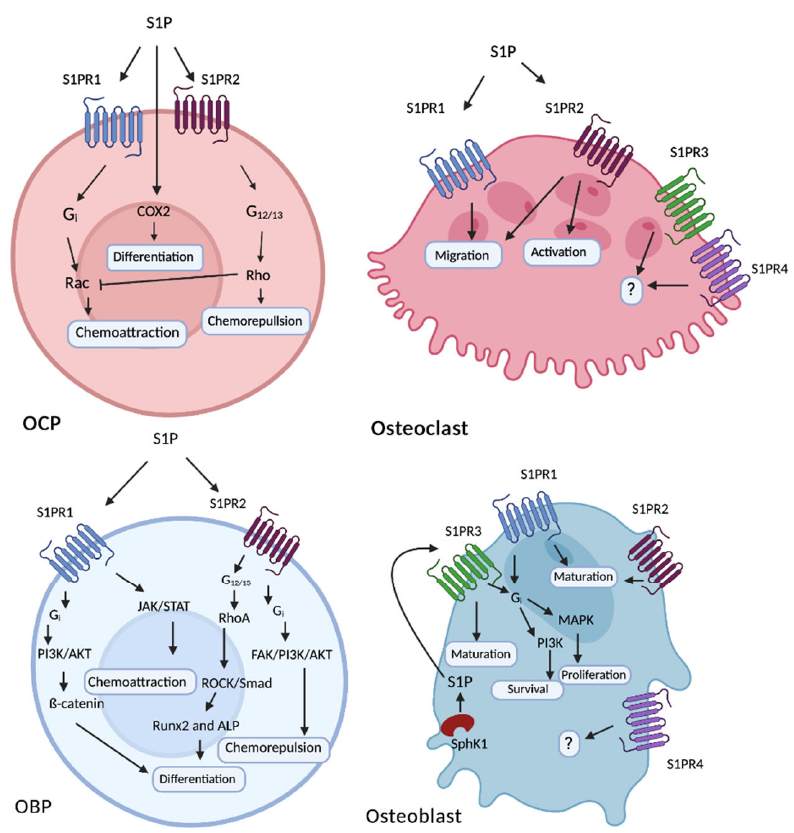
Figure 2. S1PR function in osteogenic cells. Schematic representation of the downstream signalling from S1PRs in osteoclast precursors (OCPs), osteoclasts (OCs), osteoblast precursors (OBPs), and osteoblasts (OBs). S1PRs are G-protein coupled receptors that activate various pathways and are present at different stages of OB and OC differentiation [17]. Within OCPs, S1PR1 and S1PR2 alter OC maturation via activation of Rho and Rac signalling pathways [24]. S1P can increase OCPs differentiation via Cox2, although the mechanism is not fully understood [24]. Although S1PR1-4 are expressed in OCs, the role of S1PR3 and S1PR4 are not currently understood [30]. S1PR1/2 can alter OC migration but the mechanisms underpinning this remain unclear. S1PR2 appears to be essential for OC activation. Within OBs, S1PR1 mediates OB differentiation via PI3K/AKT signalling and regulates migration via JAK/STAT signalling [31], resulting in chemoattraction in response to S1P [31], whereas S1PR2 increases OB differentiation via RhoA/ROCK/Smad signalling [30] and can also act through FAK/PI3K/AKT signalling to promote chemorepulsion. In OBs, S1PR1 increases OB proliferation [32] and survival via MAPK and PI3K signalling. S1PR1-3 are involved in mediating OB maturation through as of yet unknown signalling pathways. Activation of SphK1 in OBs promotes osteoblast maturation via autocrine S1P signalling through S1PR3 [23]. The function of S1PR4 in OBs is currently unknown. Created in Biorender.com.